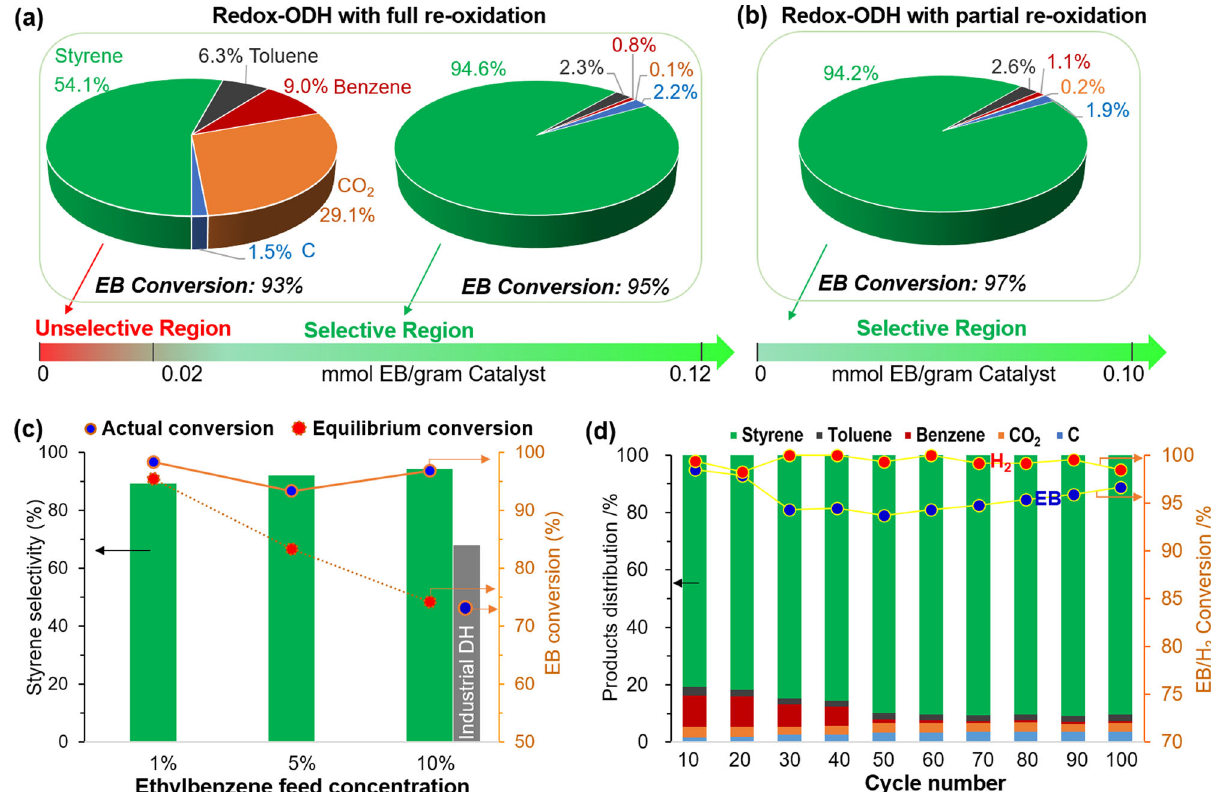
Fig. 2 Redox-ODH performance. Performance comparison of redox-ODH of ethylbenzene (EB) with a fully reoxidized and b partially reoxidized redox catalyst, EB partial pressure = 0.01 atm, temperature = 600°C. c ODH performance comparing to DH equilibrium conversions in the range of 0.01 – 0.1 atm ethylbenzene feed partial pressure (balance Ar) using partially reoxidized redox catalyst. d Long-term cycle and product distributions in redox-ODH using fully reoxidized redox Fig. 2d. Aside from a gradual increase in styrene selectivity over the fi rst 50 cycles, stable and satisfactory redox catalyst perfor- mances were observed over the 100 cycle continuous testing with complete reoxidation of the redox catalyst. Coke formation was <5% and was completely removed during the reoxidation step. It is noted that the redox-ODH performance relies on the participation of lattice oxygen species and deeply reduced (lattice oxygen-deprived) (Ca/Mn) 1 − x O@KFeO 2 exhibits much lower ethylbenzene conversion and H 2 by-product conversion (Supplementary Fig. 3). Further characterization of the redox catalyst and the reaction mechanism is discussed next.